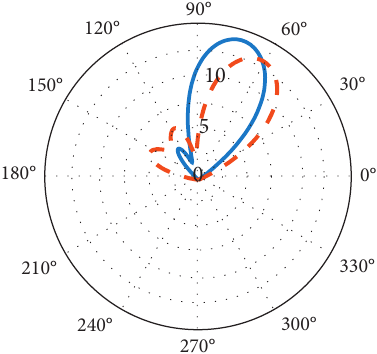
Figure 2: Resulting azimuthal diagrams of applying the phase shift mode to the Yagi–Uda array of Figure 3, with the purpose to point the beam to θ o � 60 ° (continuous line) and θ o � 30 ° (dashed line).